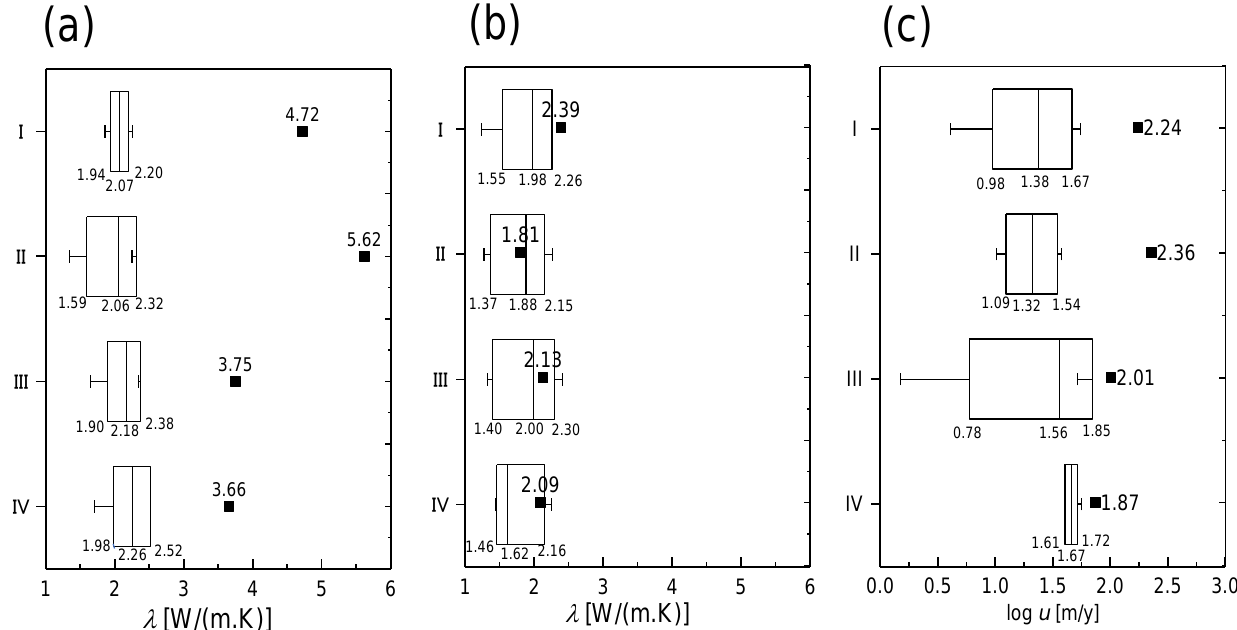
Figure 7. Box plots of vertical partial λ ( a ) in the ILS solution and ( b ) in the MLS solution with the logarithms of Darcy velocity u ( c ) at seven BHEs and individual plots for BHE No. 3. The central line in each plot denotes the median, the box denotes the standard deviation, and the bars denote the range.